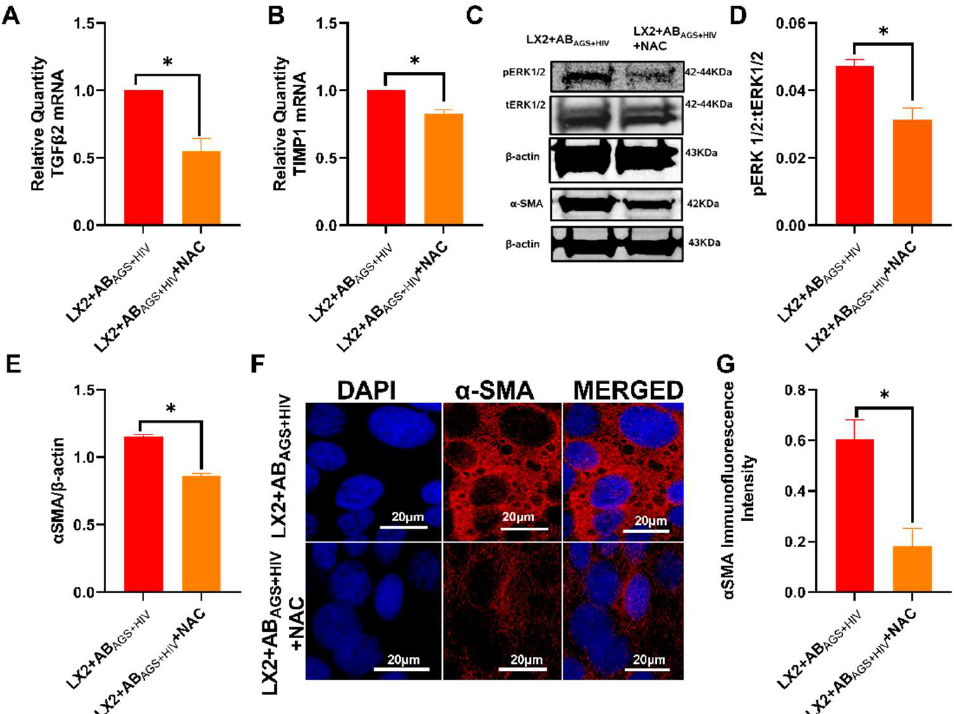
Figure 7. NAC treatment reverses or prevents profibrotic activation of LX2 cells by inhibition of ERK1/2 pathway: RT-PCR analysis of ( A ) TGF β 2 mRNA and ( B ) TIMP1 mRNA. ( C – E ) Phopho- ERK1/2 and α -SMA were measured by immunoblot analysis and the quantification of immunoreac- tive blots. Equal amounts of protein (20 µ g) were loaded in each lane. β -actin was used as an internal control. ( F ) Immunofluorescent staining of α -SMA. Staining was visualized using a Keyence BZ-X810 fluorescence microscope. Pictures are representative data from three independent experiments. ( G ) Quantification of α -SMA by NIH ImageJ. Data are from 3 independent experiments presented as mean ± SEM. Bars with * are significantly different from each other ( p ≤ 0.05).